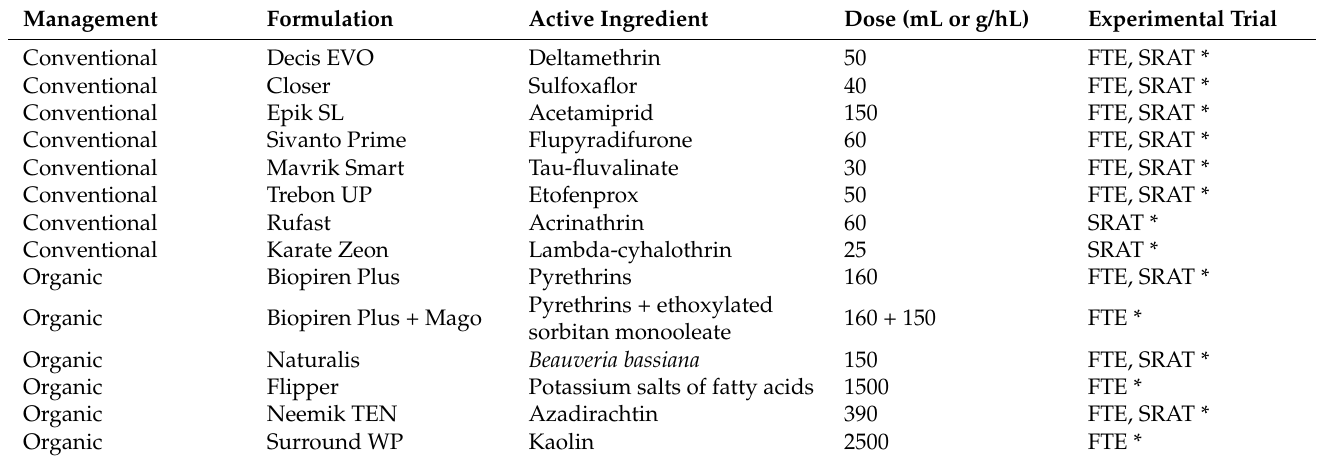
Table 1. Characteristics of insecticides investigated in the different experimental